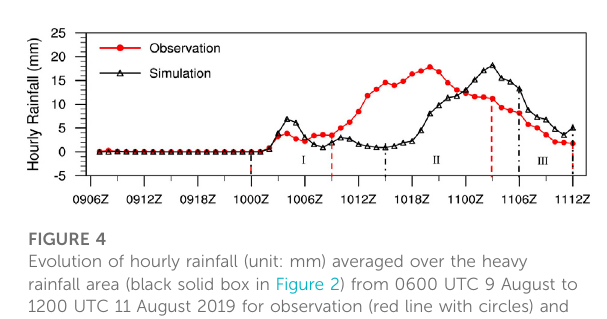
FIGURE 4 Evolution of hourly rainfall (unit: mm) averaged over the heavy rainfall area (black solid box in Figure 2) from 0600 UTC 9 August to 1200 UTC 11 August 2019 for observation (red line with circles) and simulation (black line with triangles). The three stages of the extreme rain event from observation (simulation) are separated by dashed (dash-dotted) lines, and I, II, and III denote the three